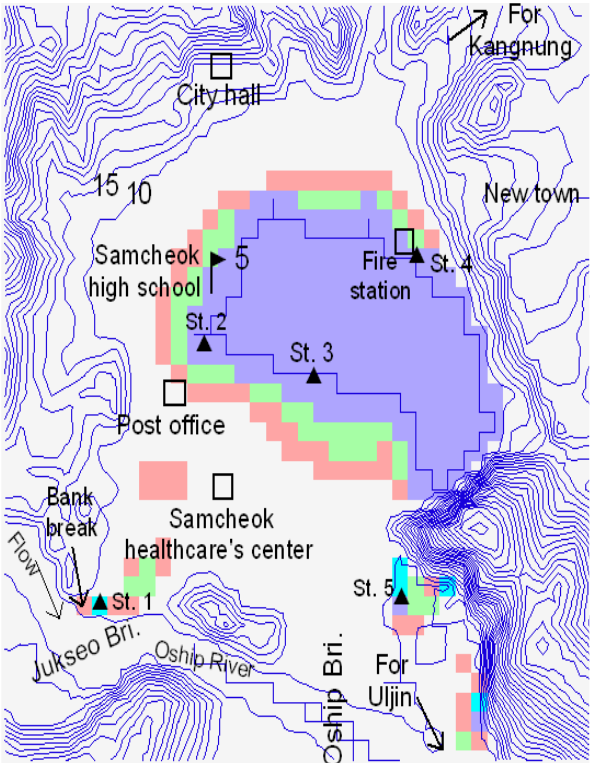
Fig. 6. Inundation depths obtained in the case of no building influence.